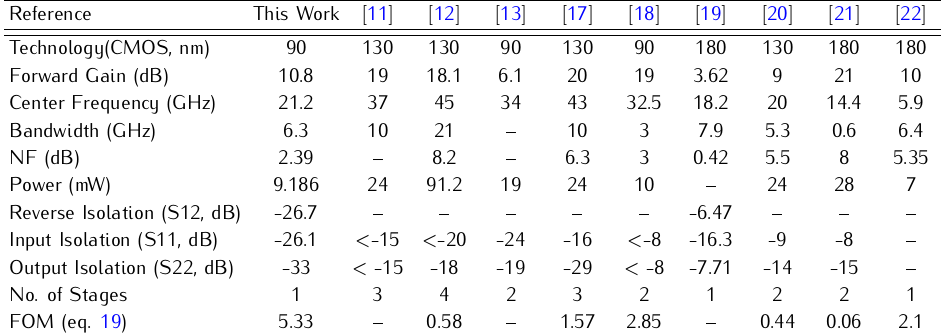
Table 1. Relative comparison of the proposed unregulated wideband amplifier with respect to published literature. Reference